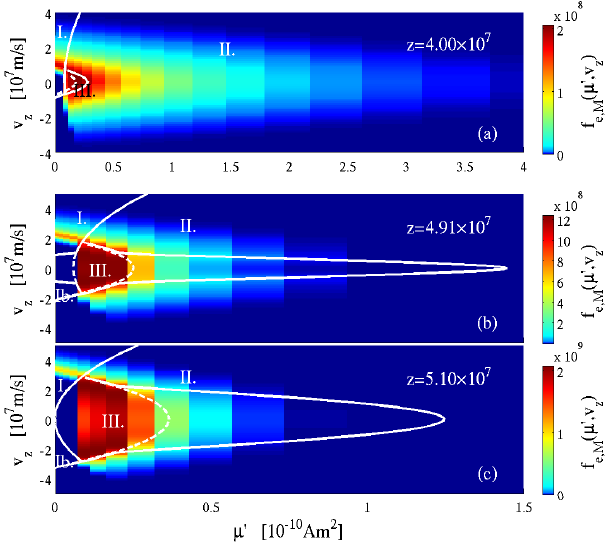
Fig. 6. Phase space densities f (µ 0 ,v z ) at t = 5 . 0s for magneto- spheric electrons at (a) z = 4 × 10 7 m; (b) z = 4 . 91 × 10 7 m; and (c) z = 5 . 1 × 10 7 m. These positions are marked in the potential and density diagrams in Fig. 3. The colour scales have been normalised so that integrals over all of µ 0 – v z space yield n s . The regions in- dicated by white lines are I: precipitating electrons; Ib: up-going electrons that will reflect and then precipitate; II: electrons which can reach the equator; and III: trapped electrons. The dashed white lines show the boundaries between the regions computed according to the theory by Chiu and Schulz (1978), and the solid lines using Eqs. (37) and (38).